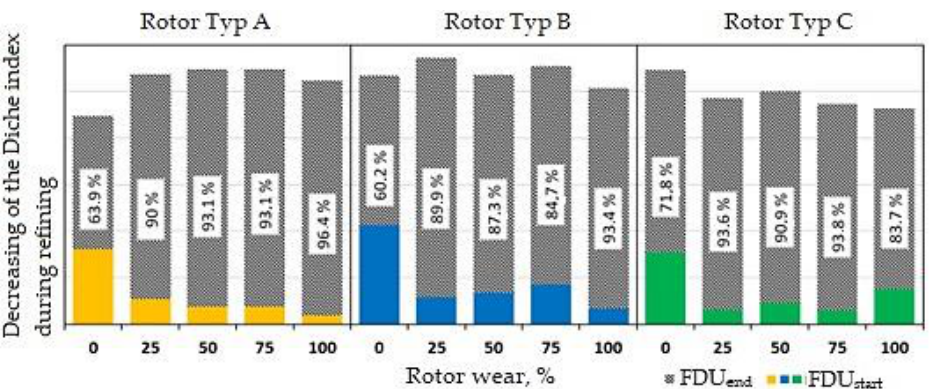
Figure 9. Efficiency comparison of individual types of rotors.